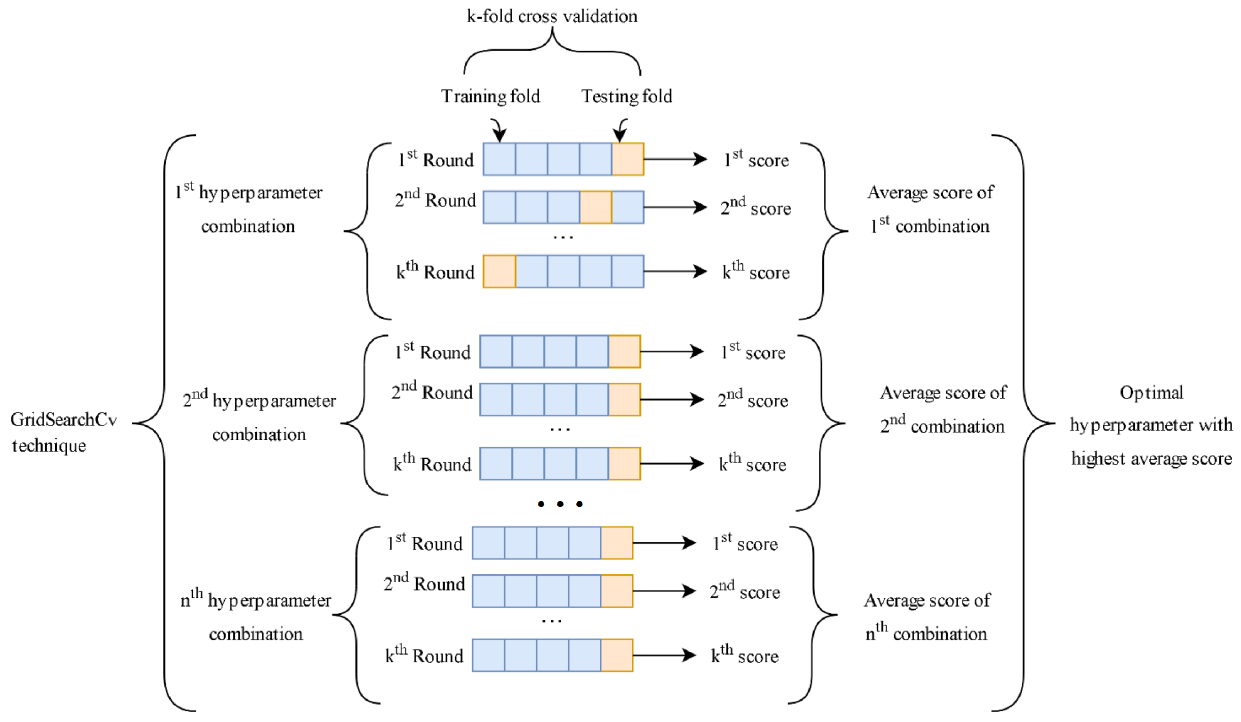
Figure 5. Hyperparameter tuning using five-fold cross validation.